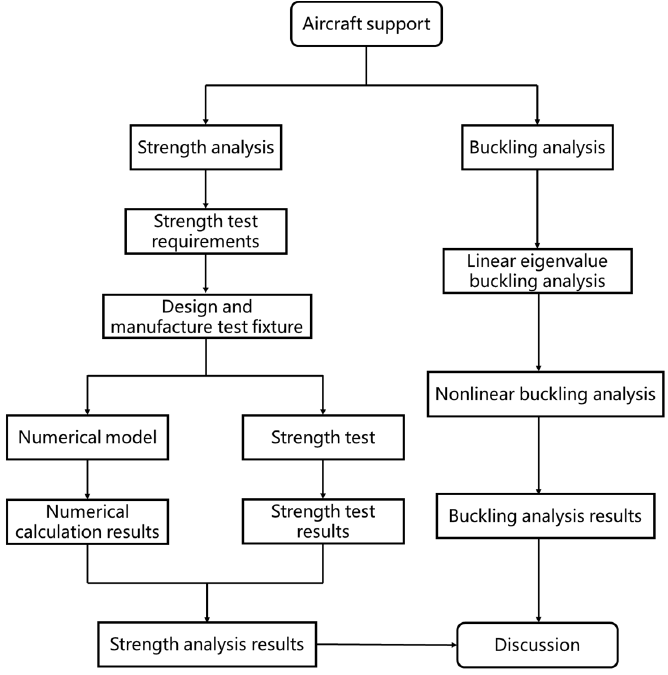
Figure 2. The main Figure 2. The main process. Figure 2. The main process.